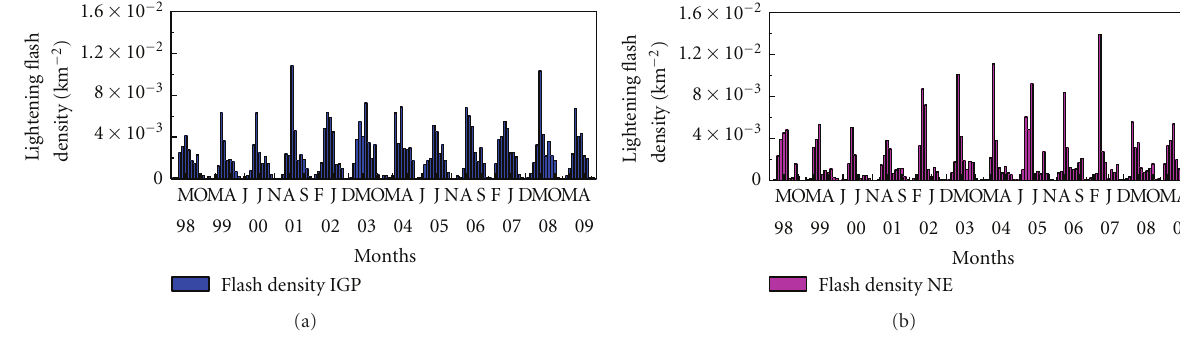
Figure 4: Monthly lightning flash density over NE and IGP from 1998–2009 as obtained by the LIS on board TRMM satellite.